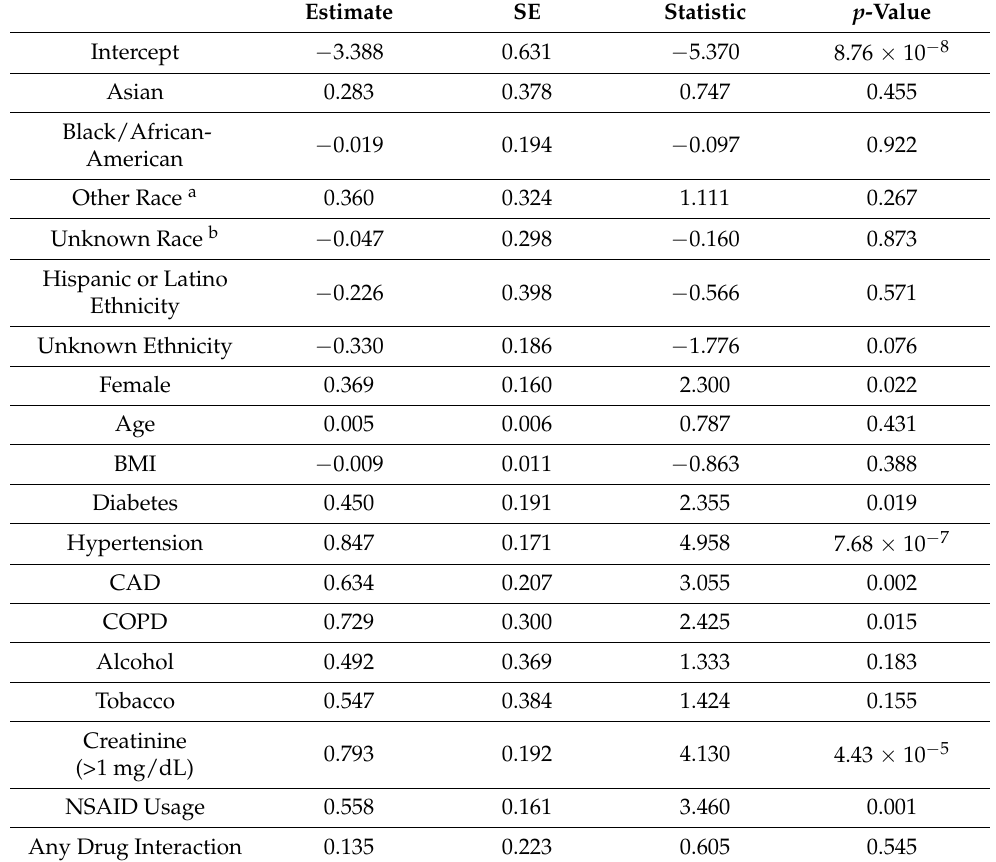
Table 2. Logistic regression model for any warfarin adverse drug reactions relative to White/European-American patients # .